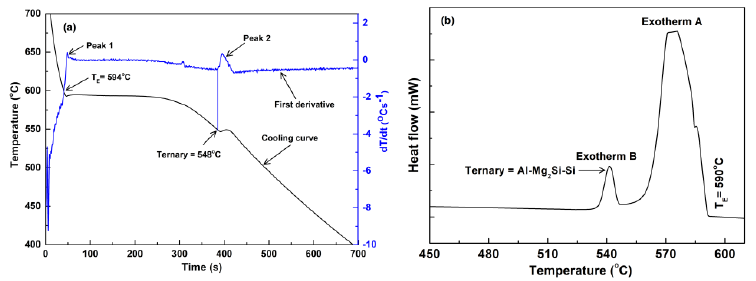
Figure 3. ( a ) Cooling curve (black) and superimposed 1st derivative dT/dt (blue) curve, and ( b ) DSC exotherms observed for the Al-13.1 wt.% Mg 2 Si alloy without the addition of chemical elements.